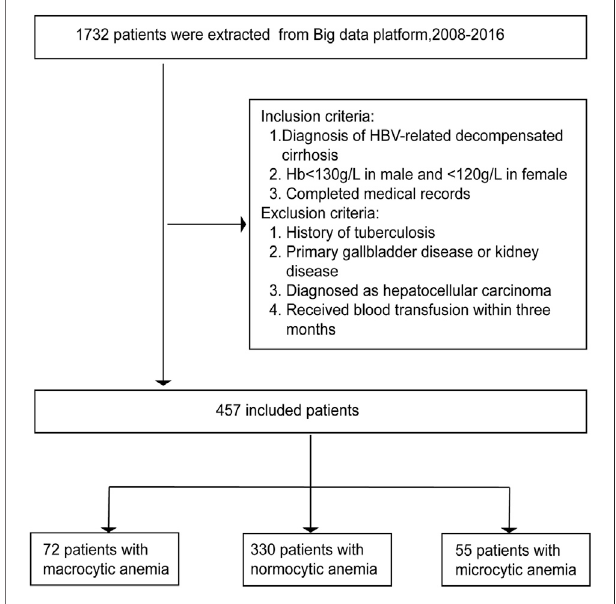
FIGURE 1 | Flow chart for the selection of